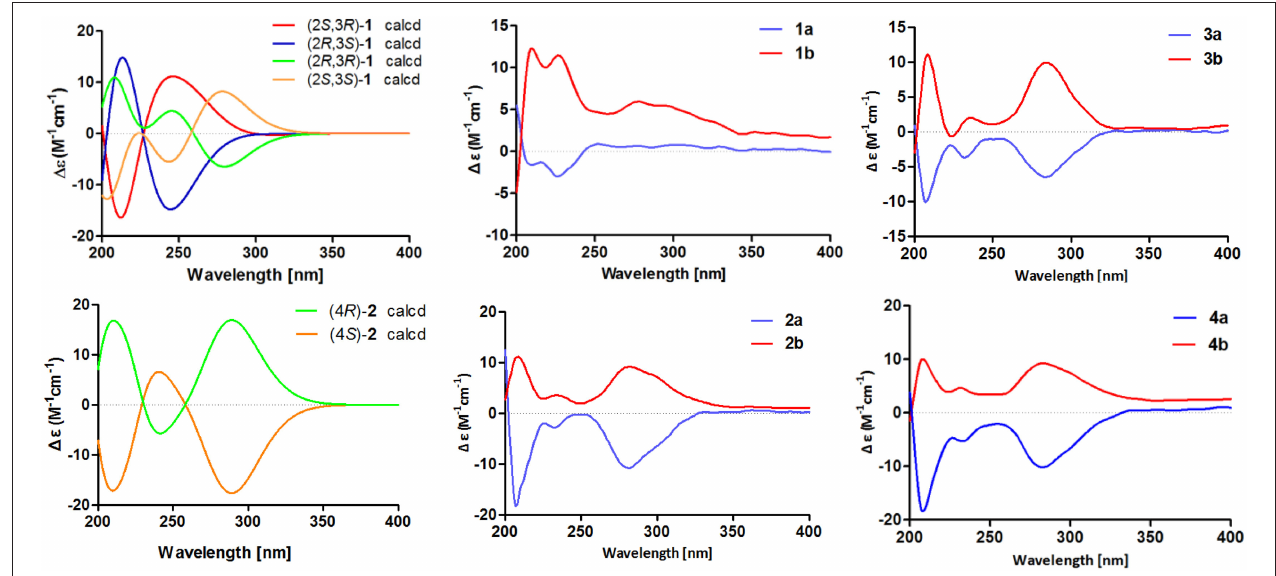
FIGURE 5 | Calculated ECD spectra of (2 S ,3 R )- 1 , (2 R ,3 S )- 1 , (2 R ,3 R )- 1 , (2 S ,3 S )- 1 , (4 R )- 2 , and (4 S )- 2 and experimental ECD spectra of 1a / 1b – 4a / 4b .